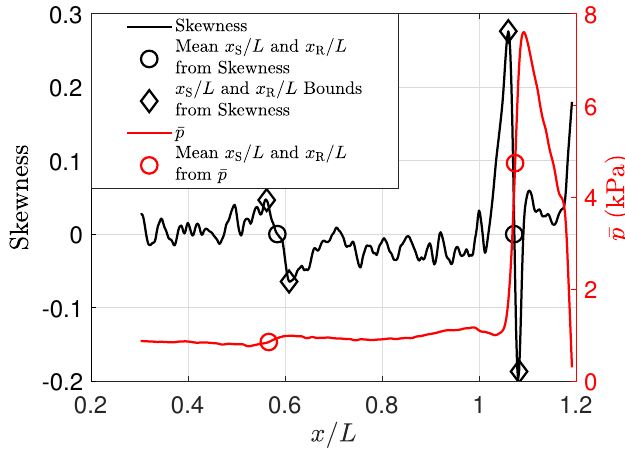
Figure 4. Centerline streamwise skewness and ¯ p profiles. The black open-diamond markers identify local maximum and minimum skewness associated with each of the shocks and demarcate the most substantially intermittent regions. The intermittent regions associated with the separation and reattachment shock feet are 0.562–0.608 and 1.060–1.082, respectively. It is important to note that the separation shock-foot data provided in Figure 4 are nearing the noise floor of the measurement system. The minimum and maximum skewness in the separation region are only about three times larger than the nearby standard deviation of the skewness profile, and one-fifth of the absolute magnitude of the skewness at